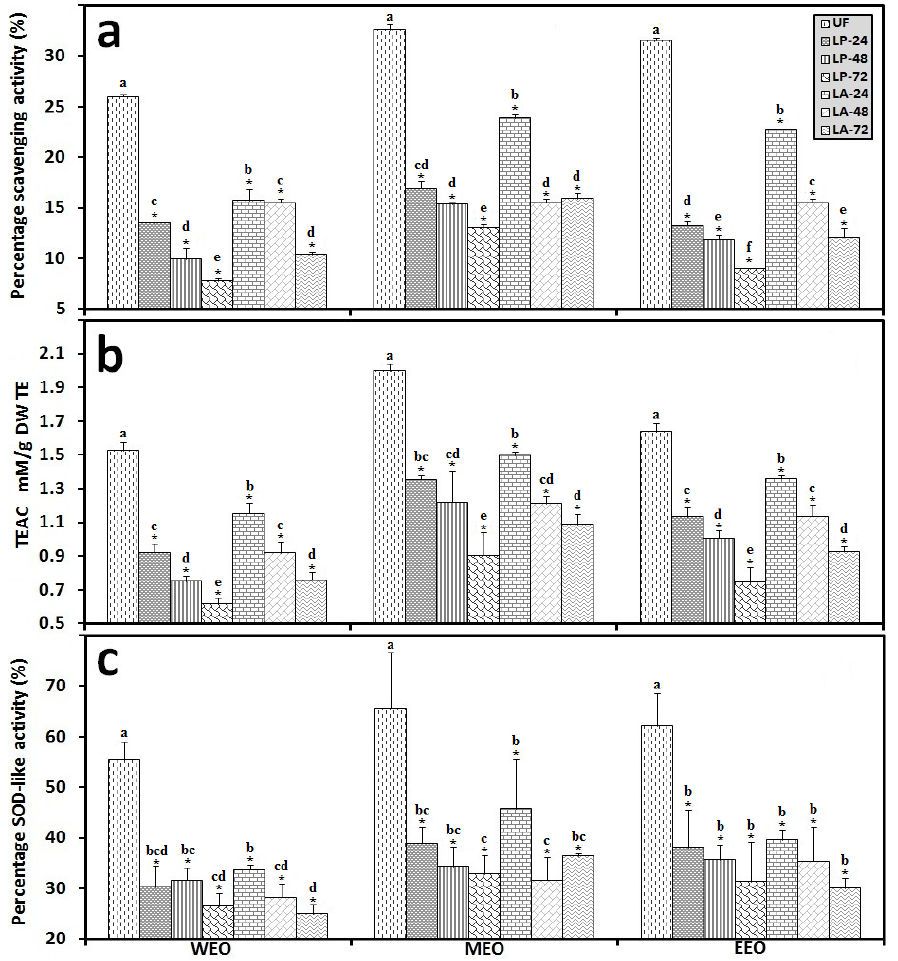
Figure 6. Antioxidant activity of IOSC subjected to SSF using three different solvent